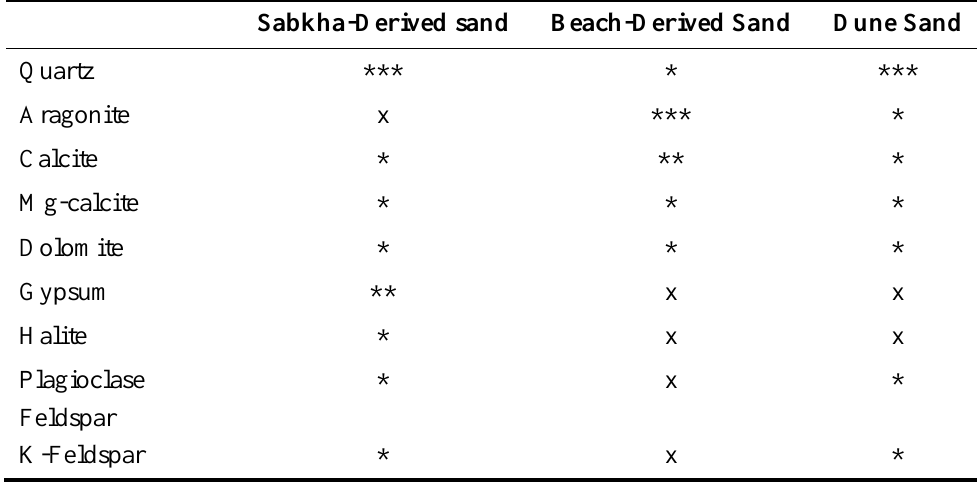
Table 6. Main Minerals as Indicated by XRD Analysis (abundant, ***; moderate, **; trace, *; none,